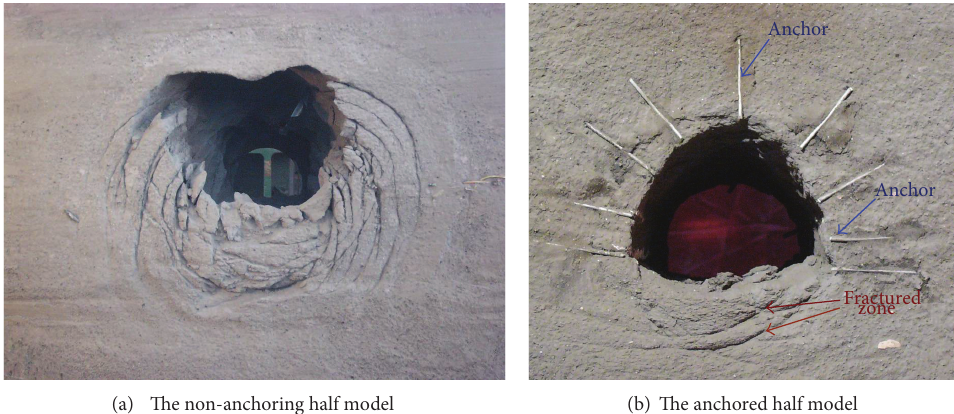
Figure 18: Failure distribution of the surrounding rock mass after tunnel